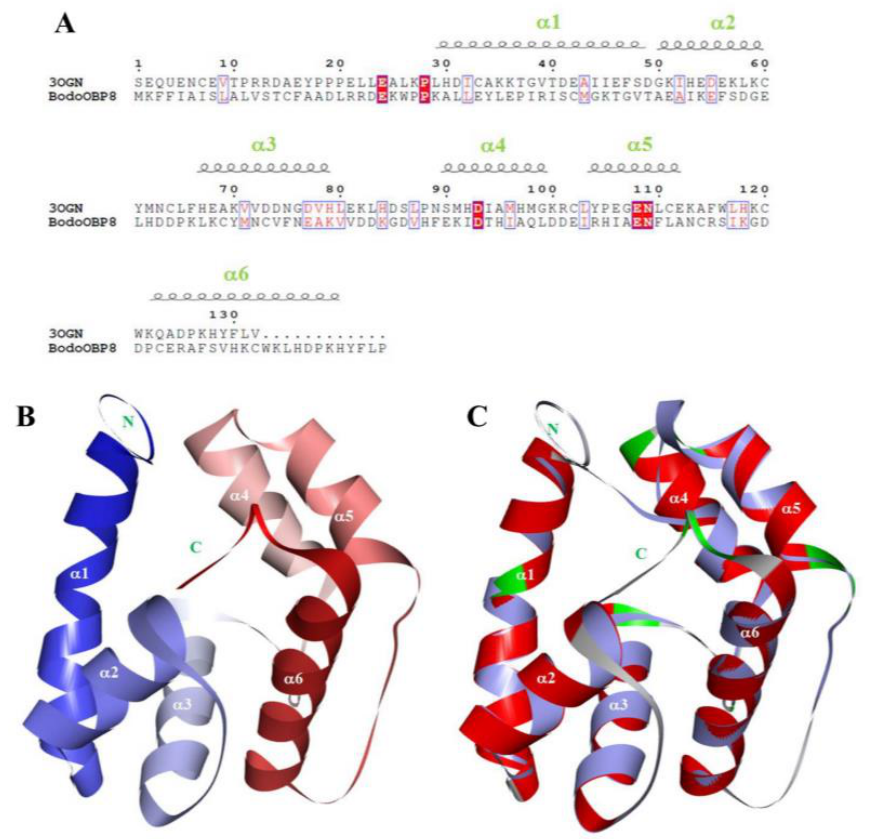
Figure 4. Homology modeling of BodoOBP8. ( A ) The sequence alignment between the template protein CquiOBP1 and the target protein BodoOBP8; ( B ) the 3D model of the target protein BodoOBP8 based on the crystal structure of the template protein of CquiOBP1 and the six α -helices are labeled in white; ( C ) the alignment plot of the target protein BodoOBP8 (red) and the template protein CquiOBP1 (purple, ID: